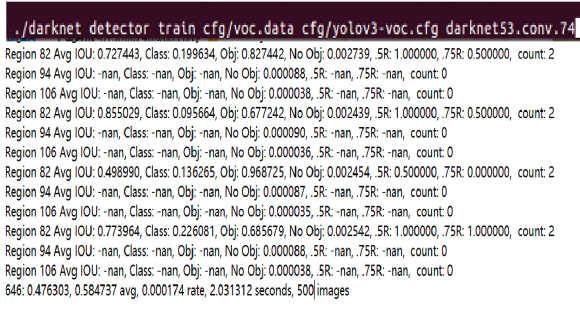
Figure 9: Training